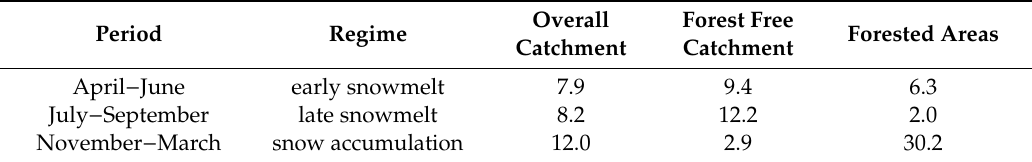
Table 3. Mean absolute error (% fSCA) between median fSCA simulated with TOPMELT and MODIS-based fSCA. Period Regime